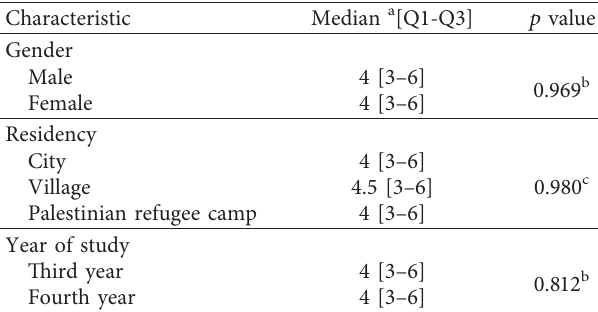
Table 12: Association between nursing students’ demographic characteristics and anti-venom score.